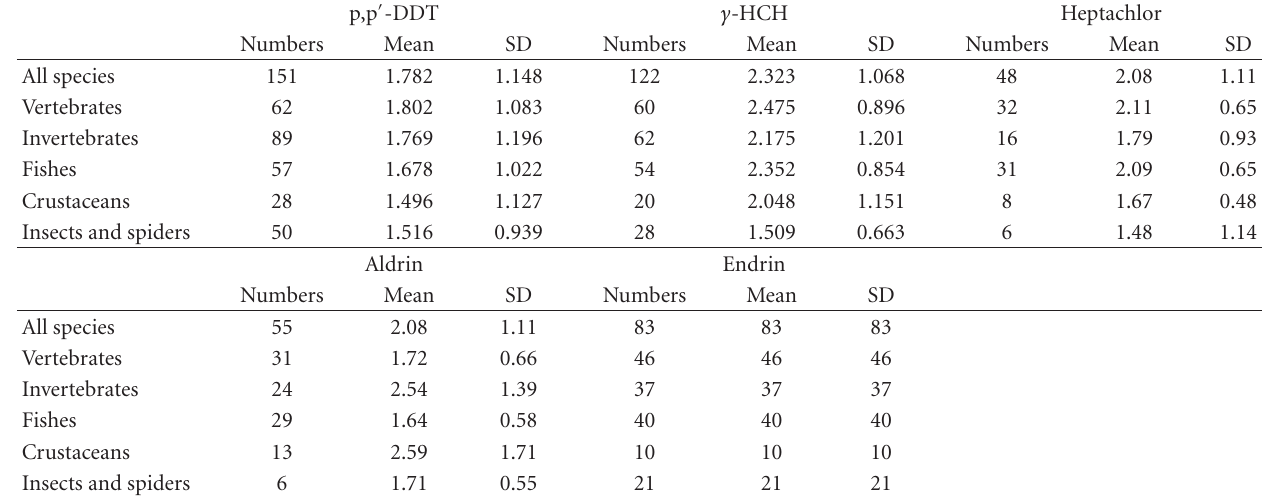
Table 2: The statistical characteristics of the log-transformed toxicity data for typical OCPs ( μ